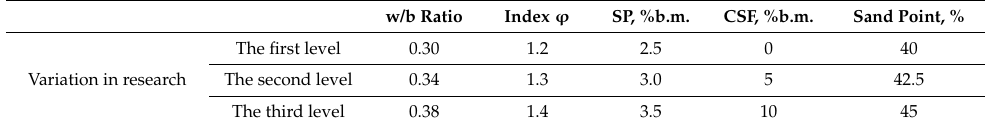
Table 5. Table of variable factors in the research in